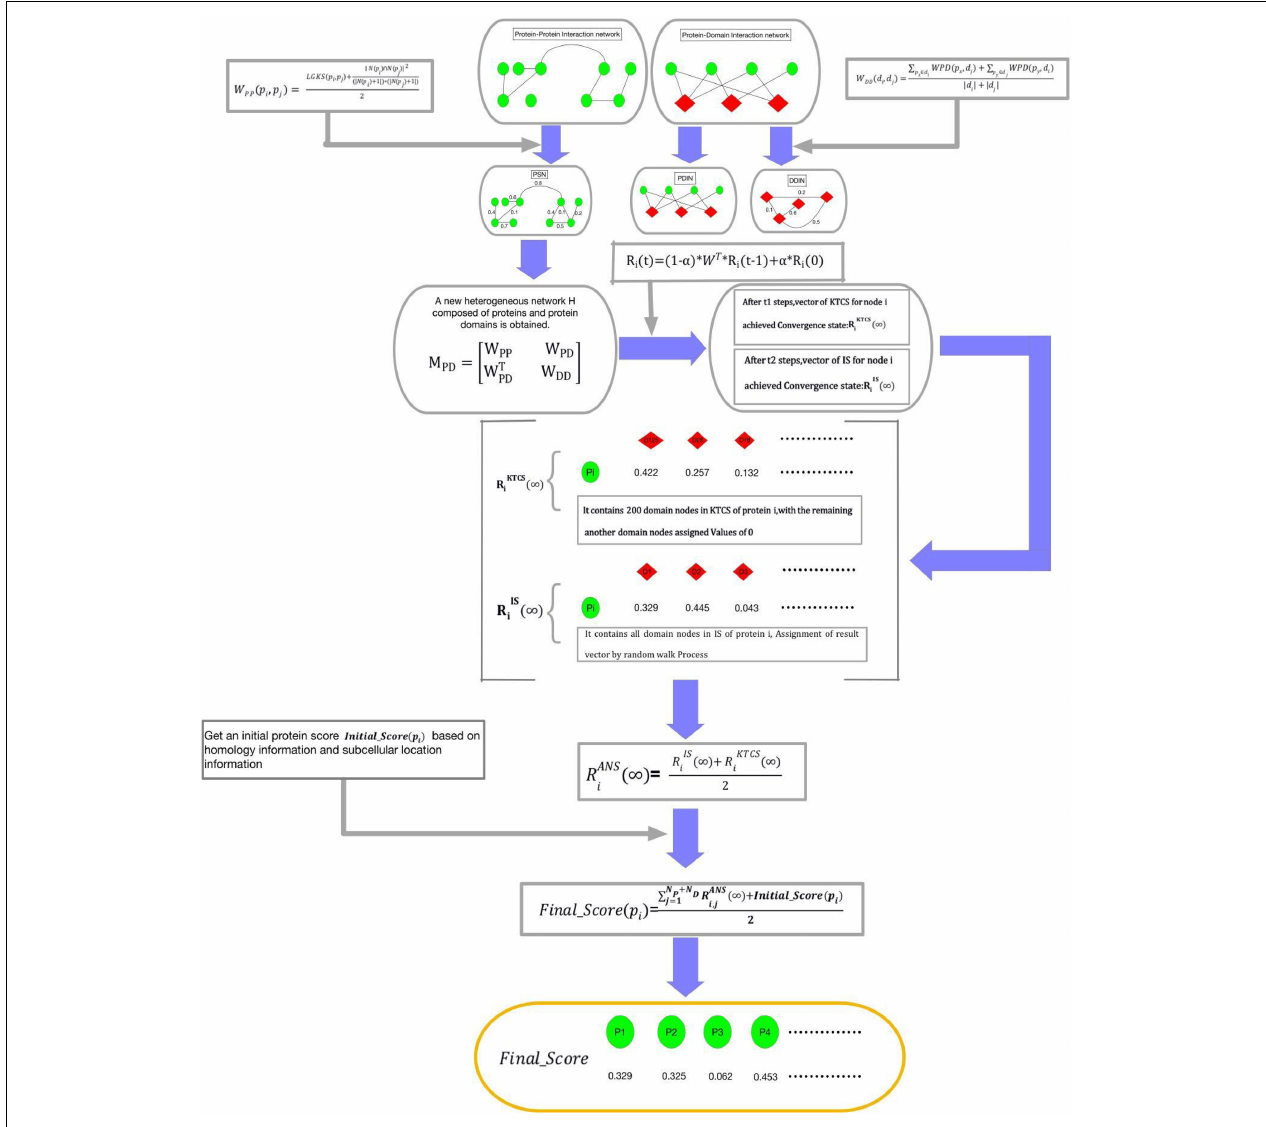
FIGURE 2 | Schematic diagram of the construction process of KTCSPM, where green nodes represent proteins and red nodes represent domains.